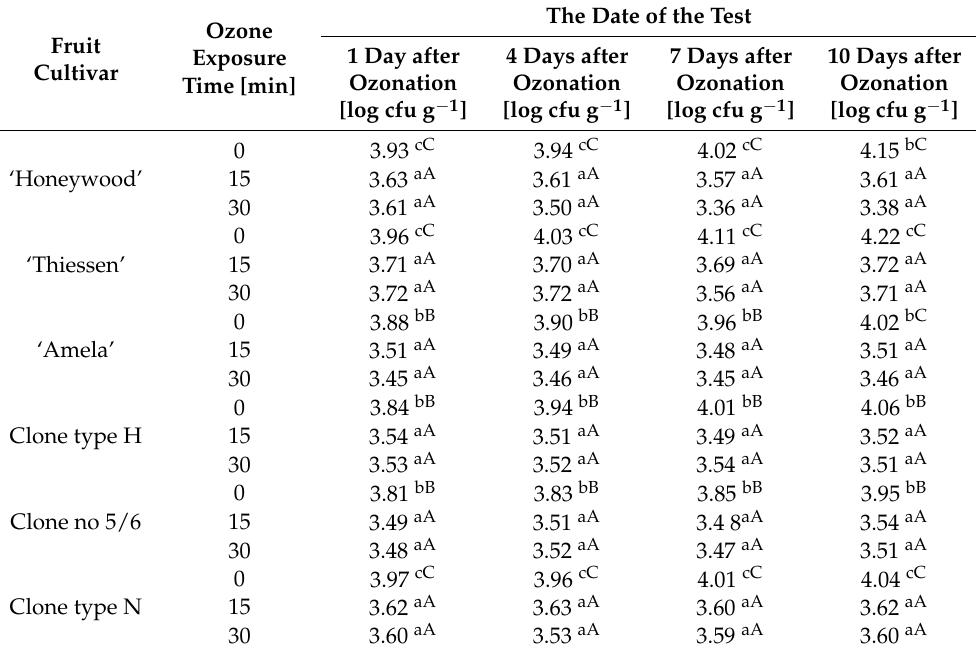
Table 2. Microbial load from yeasts and molds of Saskatoon berry fruit during storage.